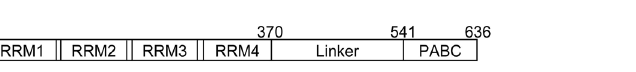
Figure 1. Domain composition of PABPC1.